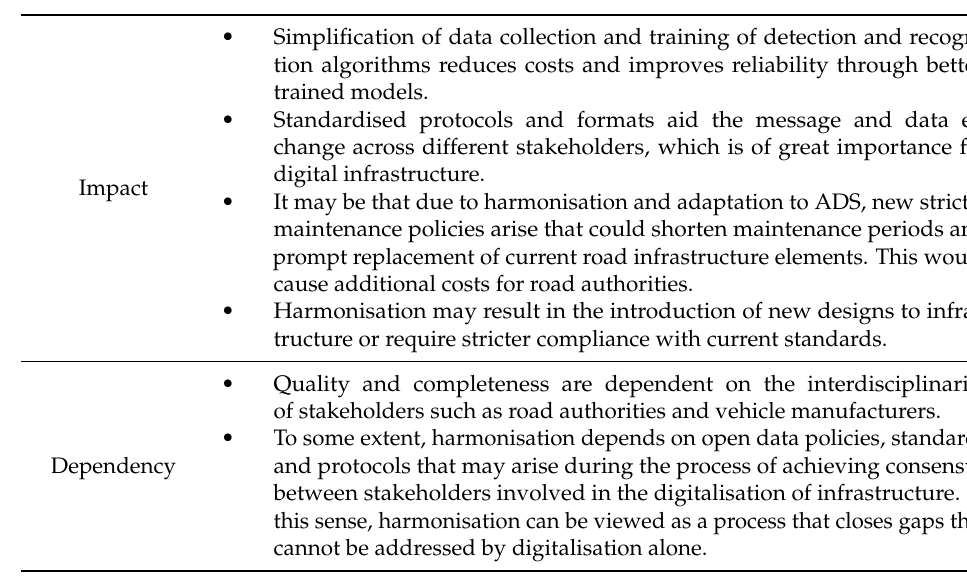
Table 10. Summary of impacts and dependencies of maintenance.